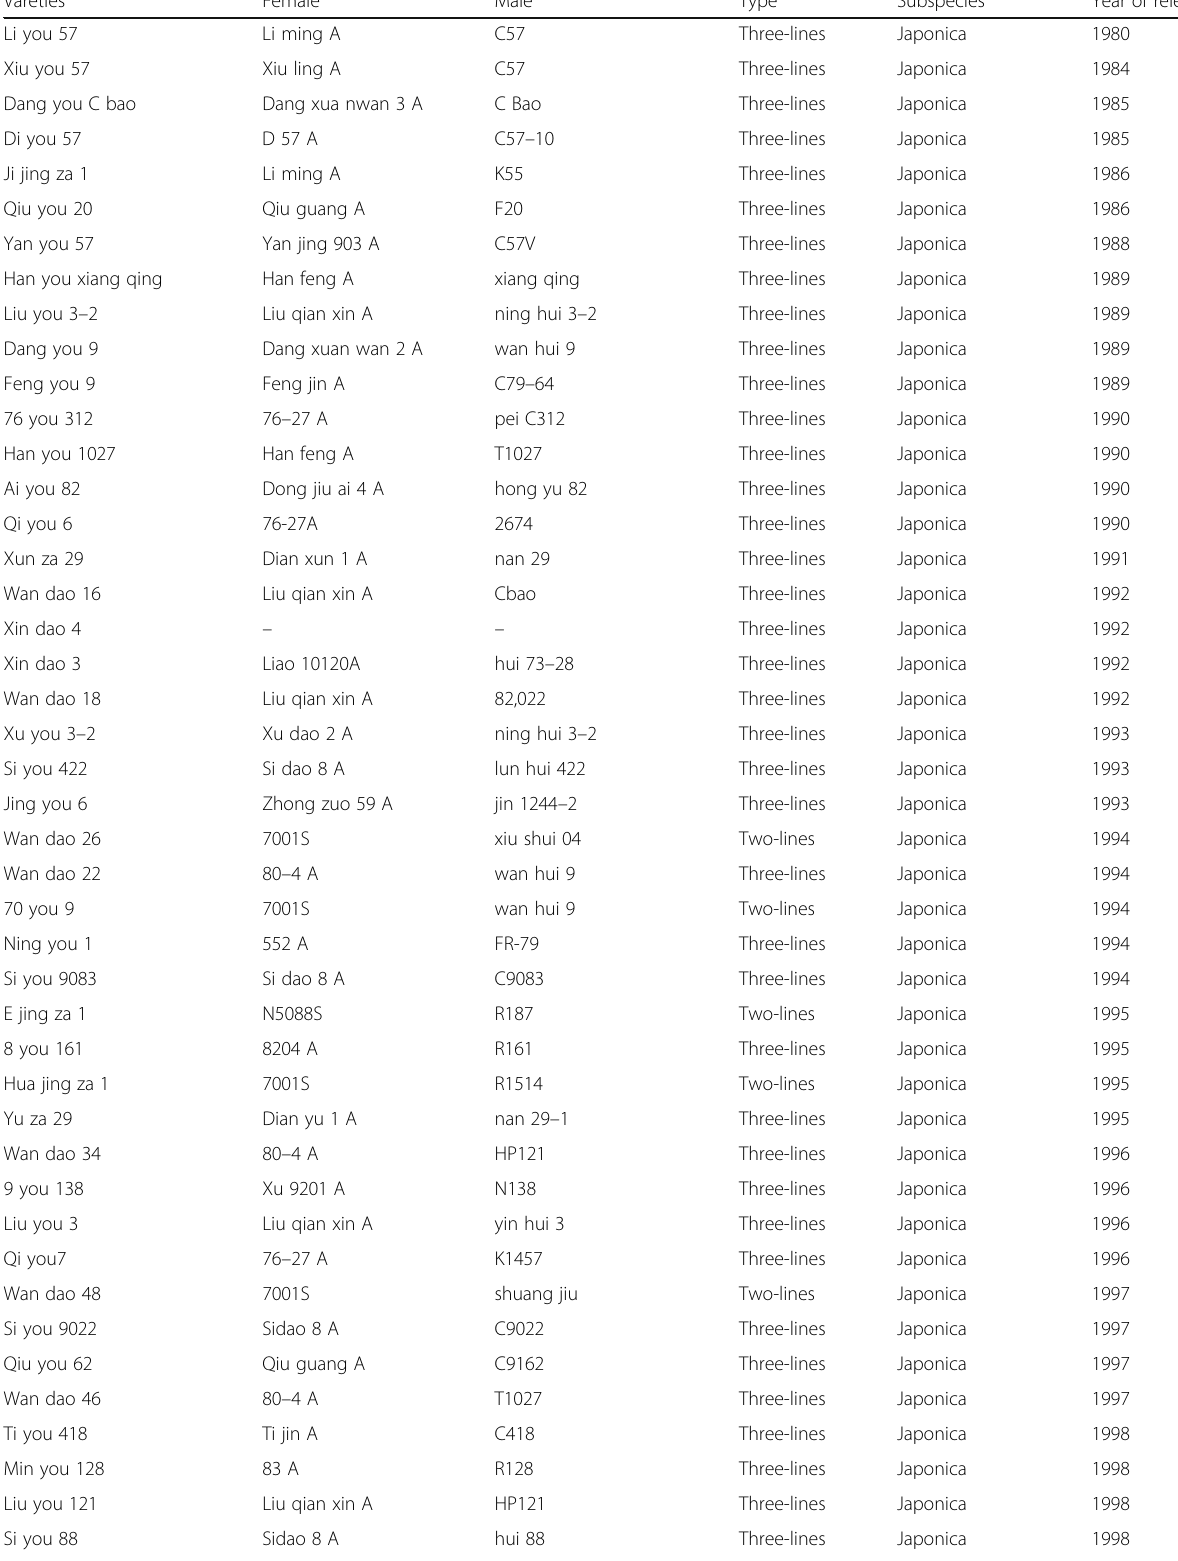
Table 1 List of hybrid japonica rice varieties bred in China